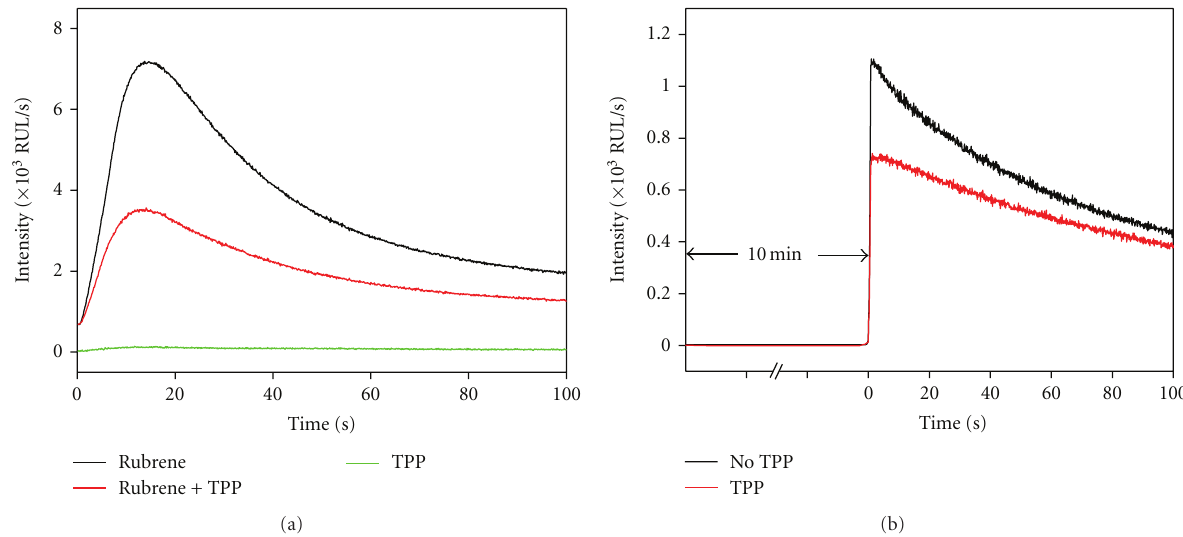
Figure 6: Chemiluminescence of (a) rubrene, rubrene plus TPP, and TPP-encapsulated POMs, respectively, in the presence of 0.2 μ M H 2 O 2 ; (b) no rubrene-encapsulated POMs with and without TPP in the presence of 0.2 μ M H 2 O 2 , and the addition rubrene (0.2mg) after 10 min. All concentrations of POMs were 2.5mg/mL, OV = − 550